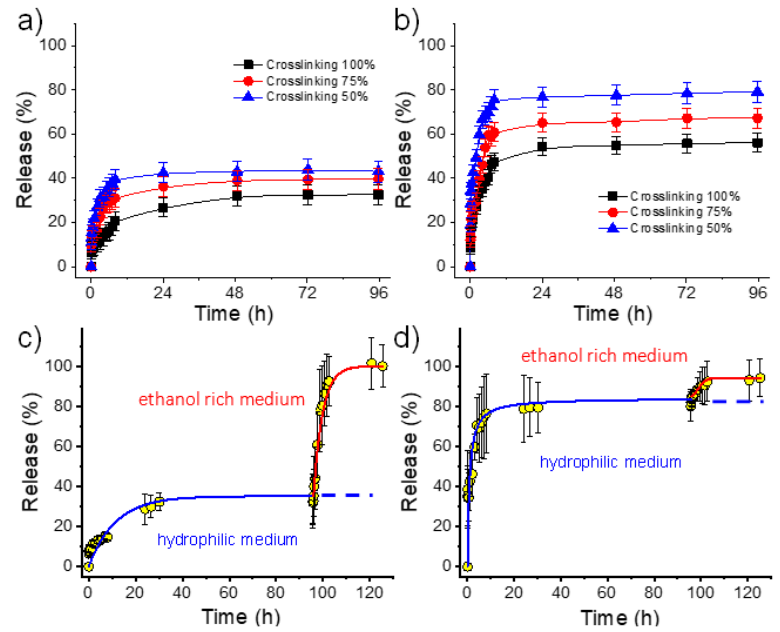
Figure 10. Relative release percentages of CHX ( a ) and PHMB ( b ) from electrospun hydrogels in PBS medium. Two-step release of CHX ( c ) and PHMB ( d ) from electrospun hydrogels with a theoretical crosslinking degree of 50%. The first step was performed in PBS and the second one in the PBS ‐ ethanol medium.